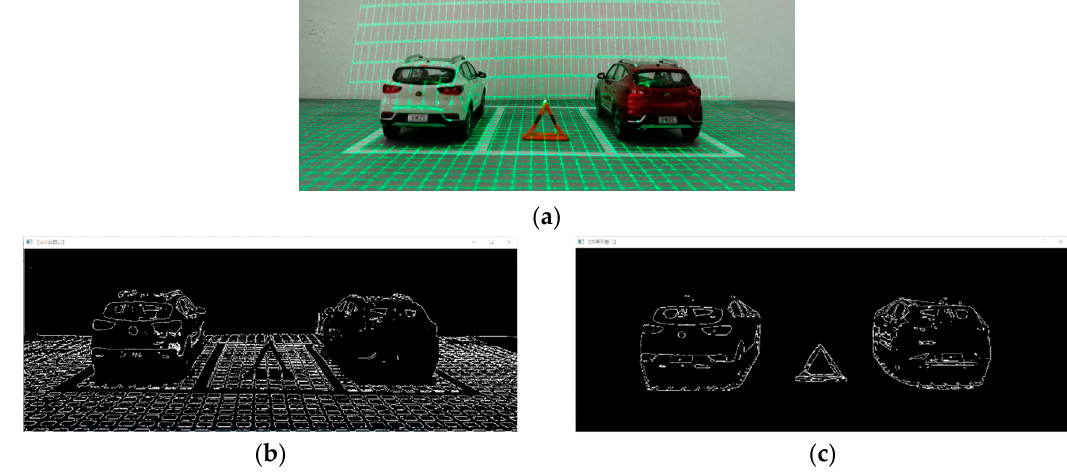
Figure 22. A parking lock exist in the parking space. ( a ) The image of the parking space; ( b ) the contour of the laser grid; ( c ) the contour of the cars and the parking lock.